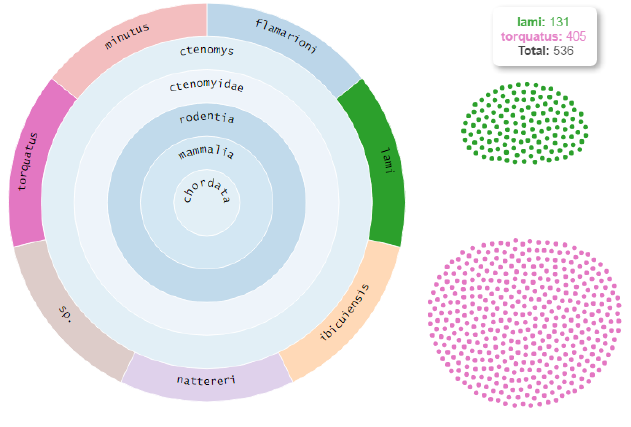
Figure 4. Sunburst visualization with the torquatus and lami species selected. Circles representing the specimens associated to these species are displayed on the right with a force-based layout. The tooltip displays the number of selected specimens when hovering over this area of the interface.